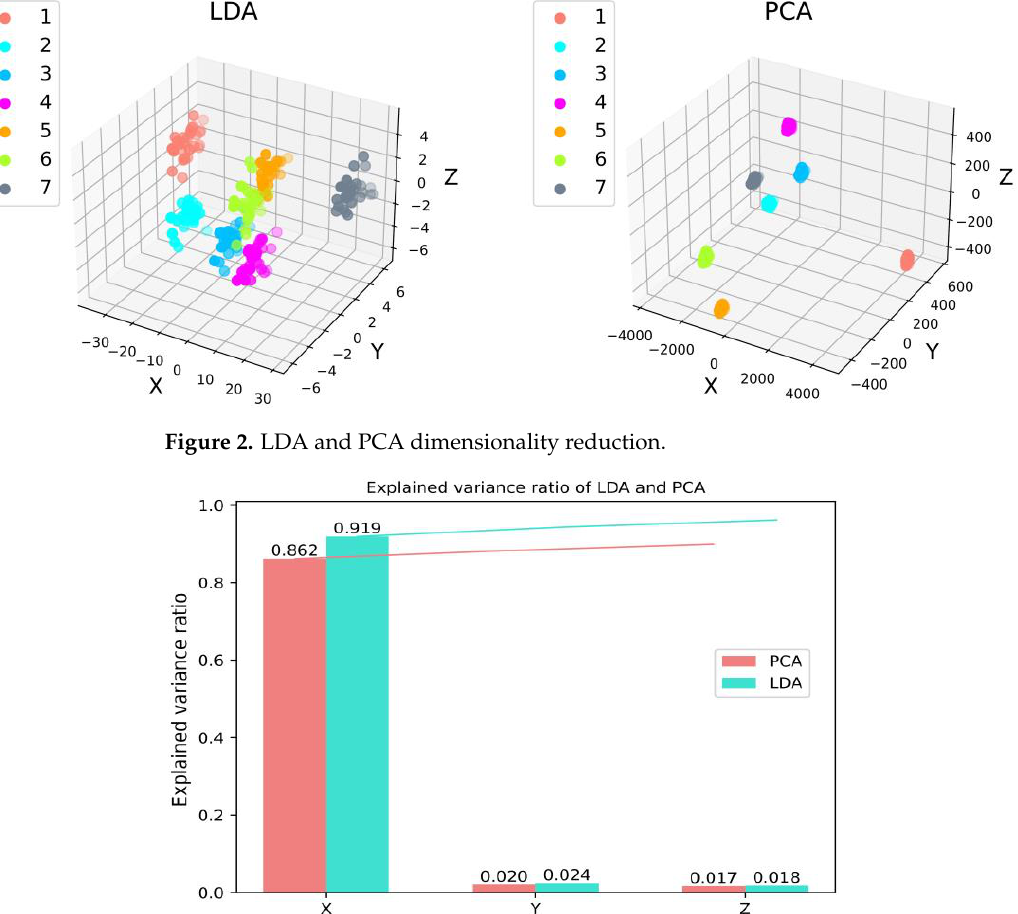
Figure 3. Explained variance ratio of LDA and PCA.